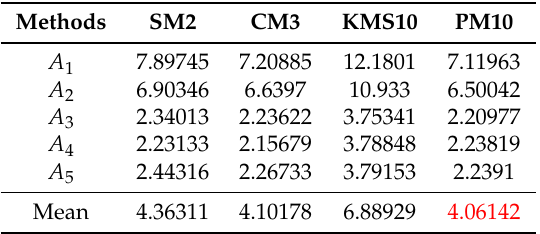
Table 4. Comparison based on the elapsed time and its mean in Experiment